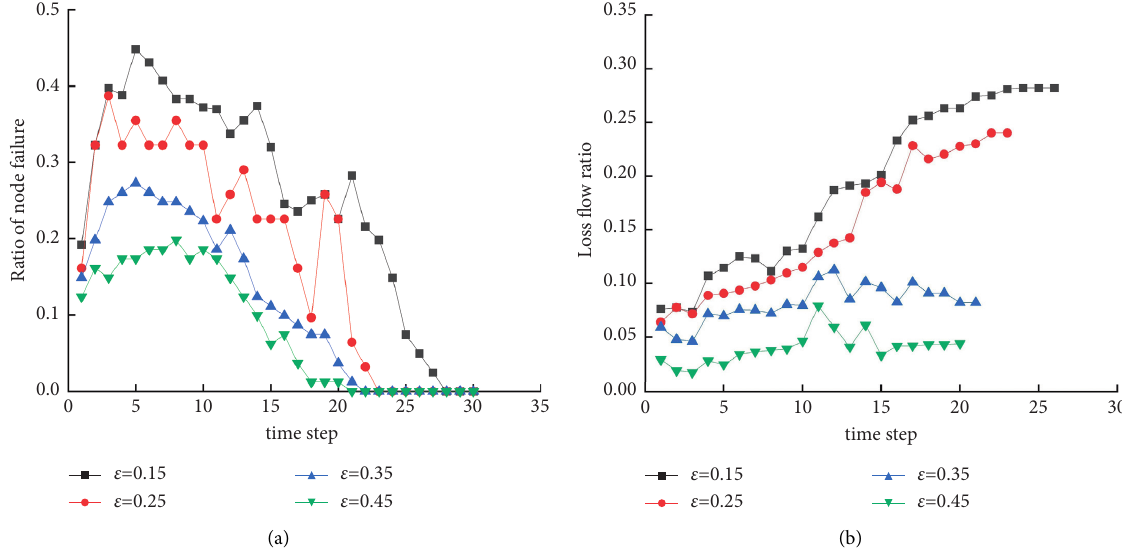
Figure 11: The vulnerability under the station with the largest degree interruption. (a) Ratio of node failure. (b) Loss flow